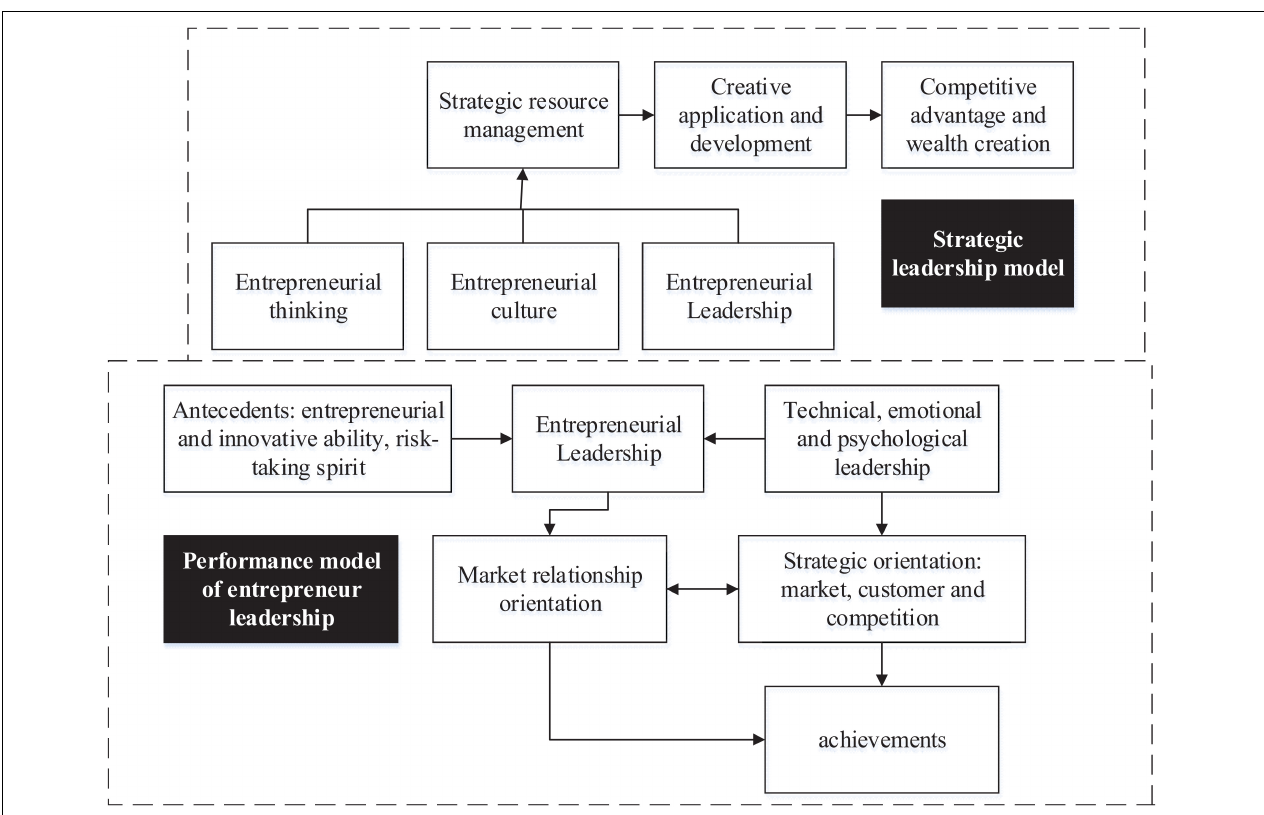
FIGURE 1 | Strategic model and performance model of entrepreneur